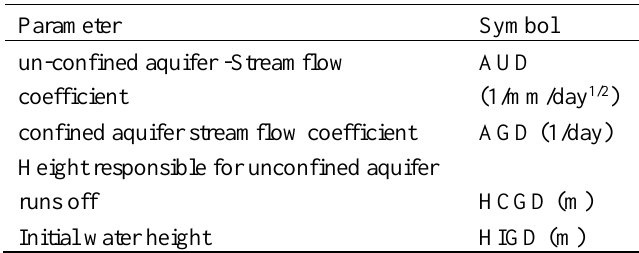
Aquifer Layer Tank Parameters Included In